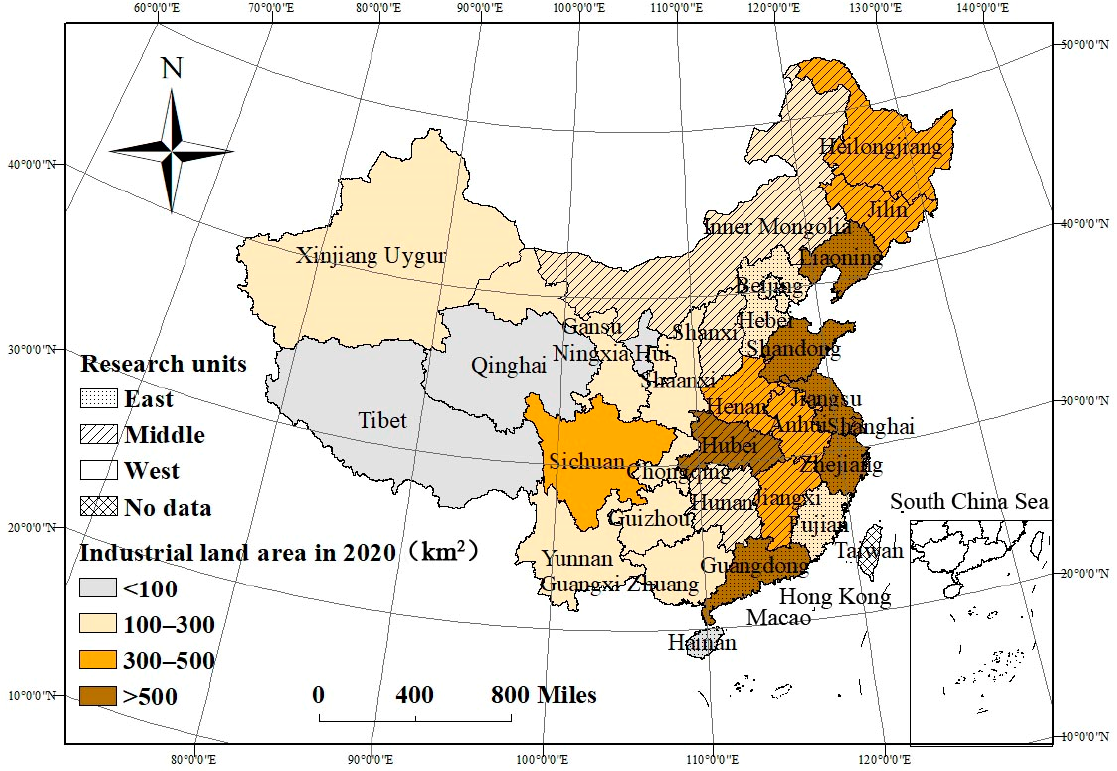
Figure 3. The distribution and industrial land area of research units. Note: The statistics were collected from the China Urban Construction Statistical Yearbook .